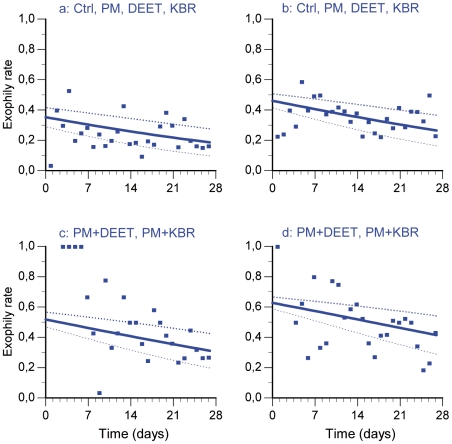
Exophily rates over time in the minimal adequate logistic regression model with standard error bounds.a and c illustrate the trial during dry season 2006; b and d illustrate the trial during rainy season 2006.